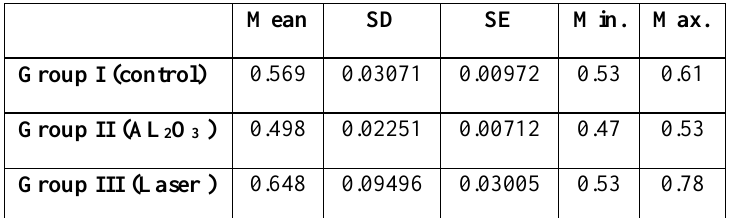
Table 1: Descriptive of shear bond strength value.